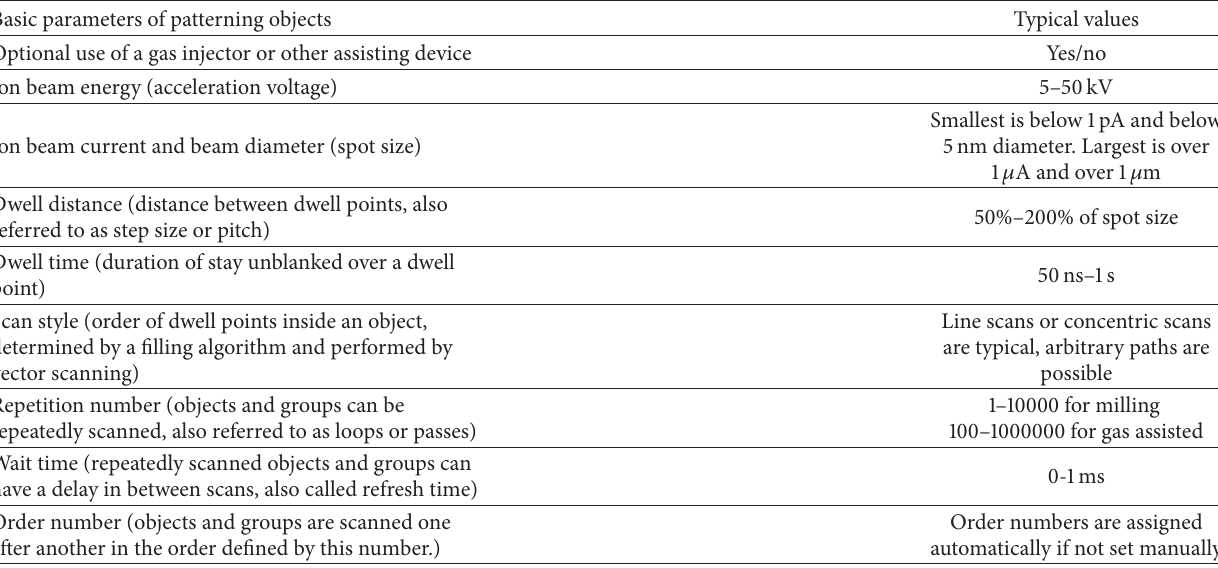
Table 4: Basic processing parameters attached to patterning objects and groups of objects and their typical values. Note that the typical values in this table are provided in general to cover various possible operating conditions in the diverse applications of IBL and that individual patterning tasks usually cover much smaller